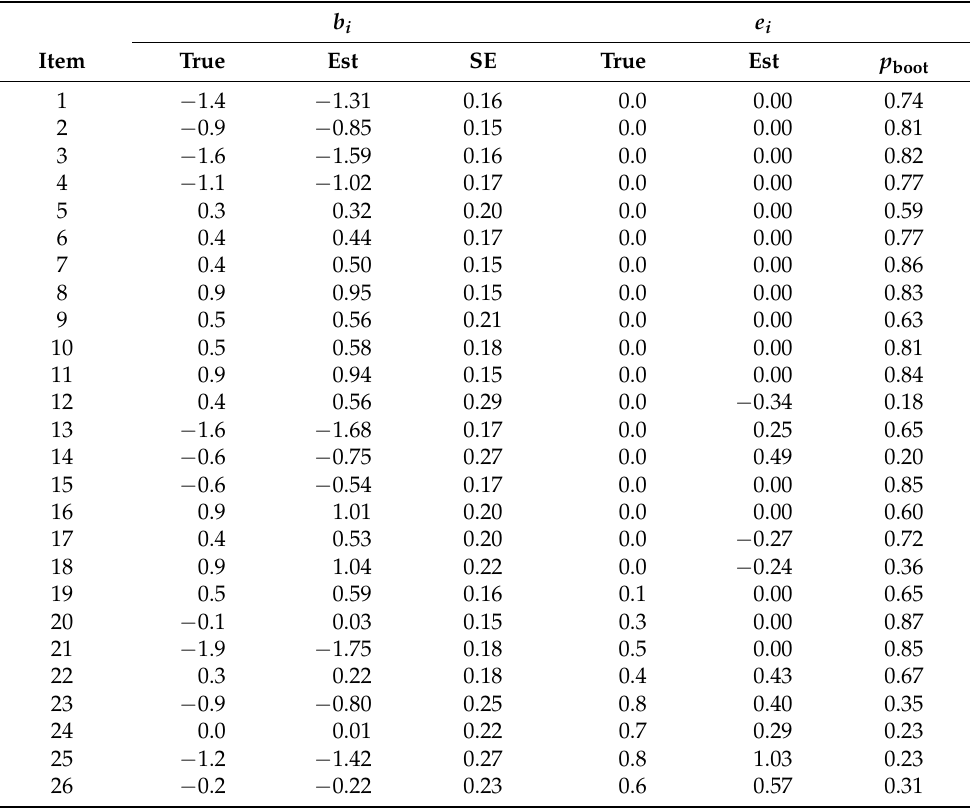
Table 4. Simulated Case Study 2: True and estimated item